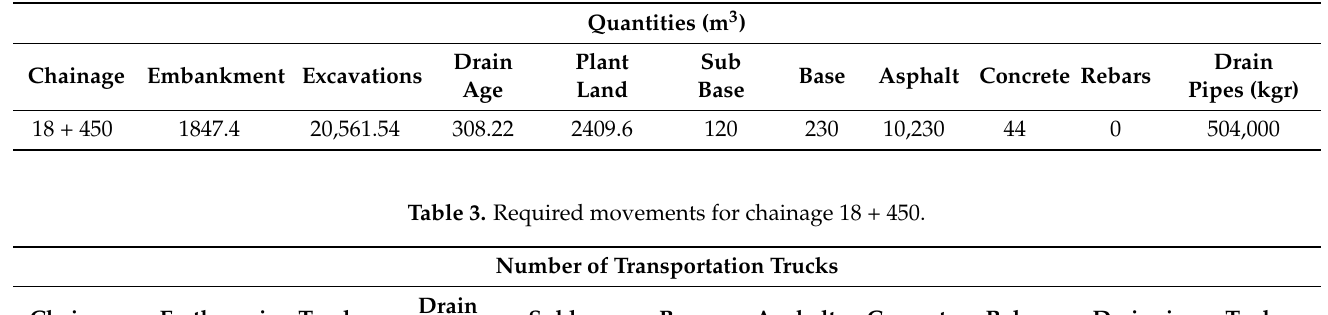
Table 2. Work quantities for chainage 18 + 450.